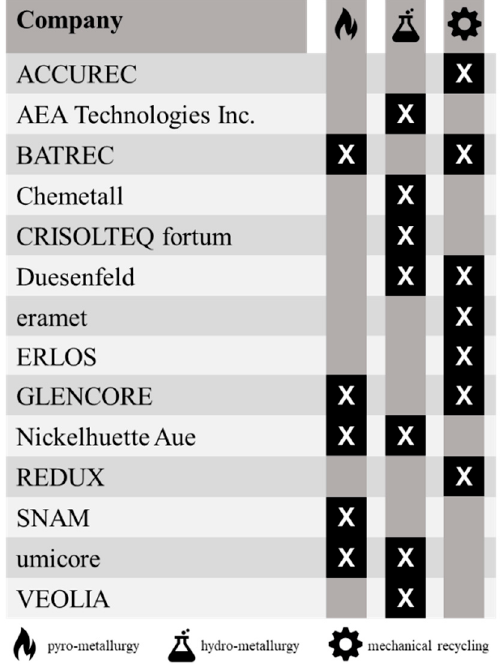
Figure 1. List of LIB-recycling companies in Europe (data based on published sources [12,18] (ERLOS), [19] (Nickelhuette Aue)) .